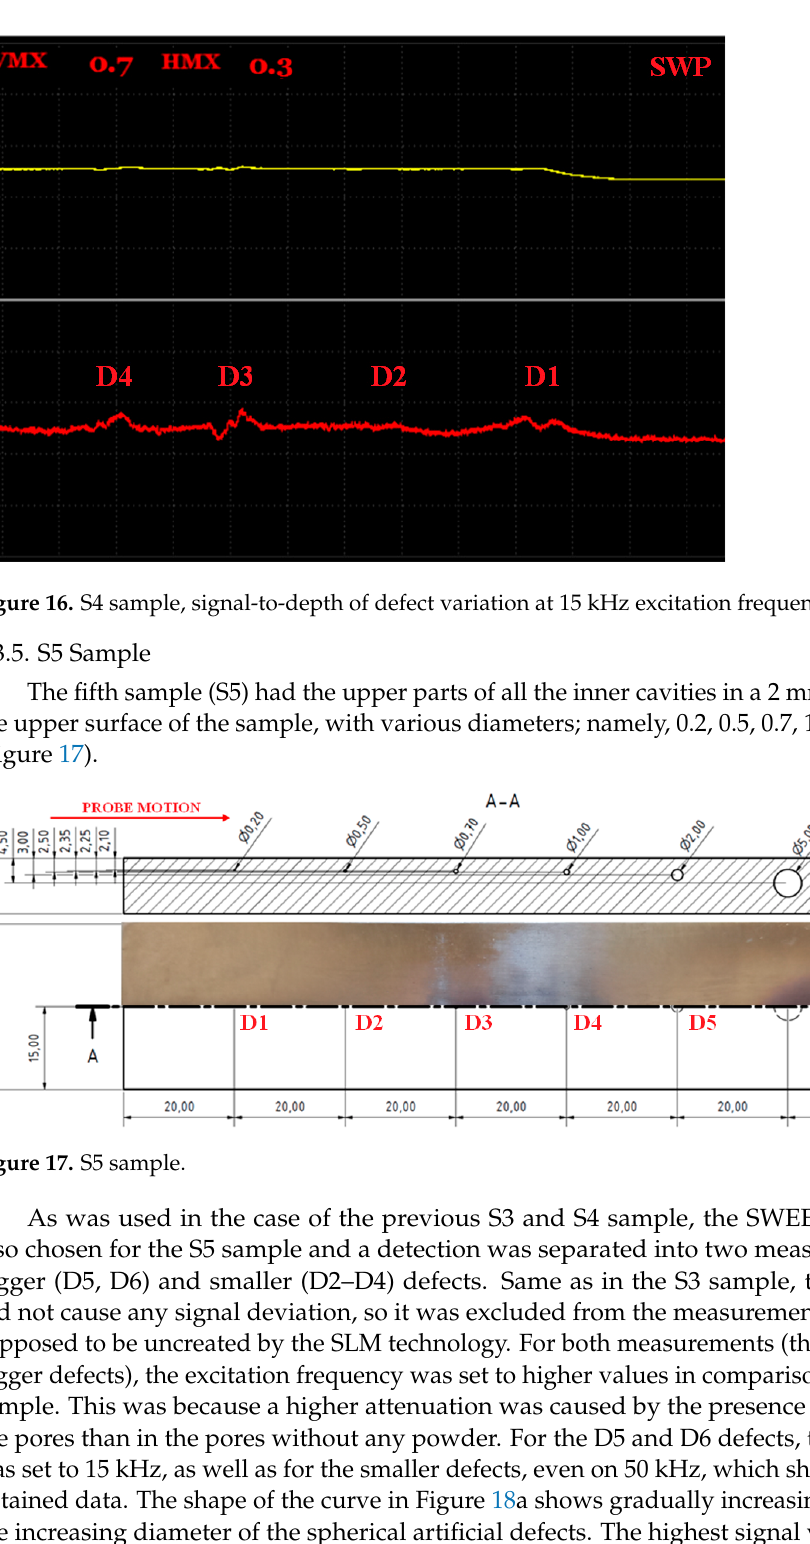
Figure 18. S5 sample, signal-to-size of defect variation; ( a ) D2–D4 defects at 50 kHz excitation fre- quency; ( b ) D5 and D6 defects at 15 kHz. 3.3.6. S6 Sample The S6 sample had cavities with the same diameter equal to 1 mm, but their positions in depth varied; namely, their upper parts had a 1.5, 3, 4.5 and 6.5 mm depth and another two cavities had a 3 mm depth, and were situated 7.5 mm from the center line in the width direction (Figure 19).